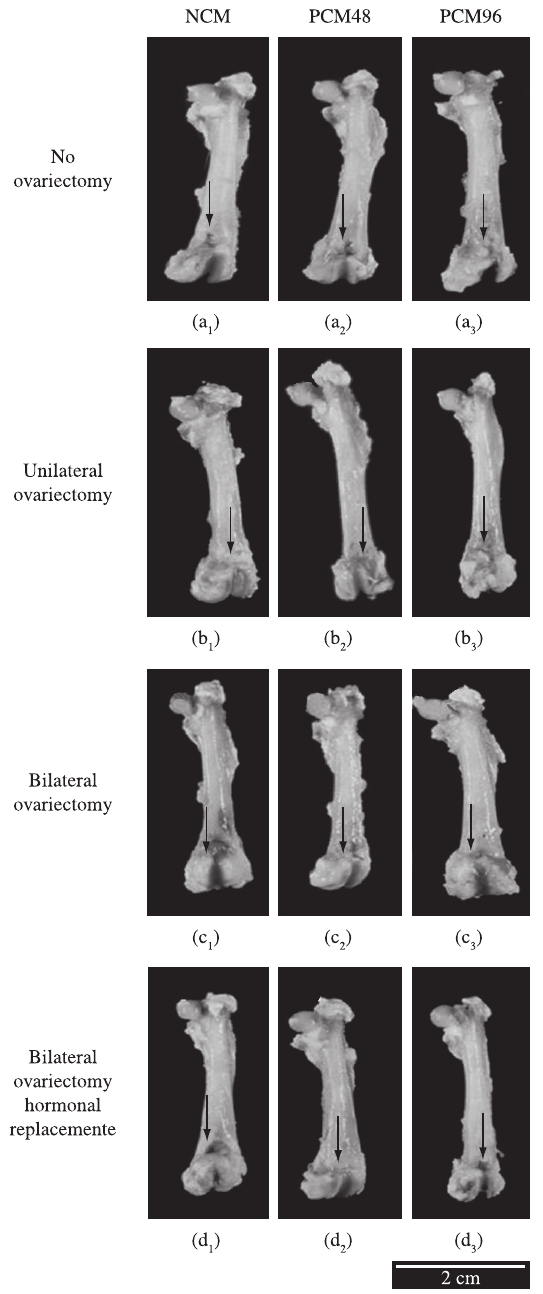
Figure 1. Macroscopic analysis of the implant areas. NCM: native collagen matrix; PCM48: polyanionic collagen matrix submitted to alkaline treatment for 48 hours; PCM96: polyanionic collagen matrix submitted to alkaline treatment for 96 hours.